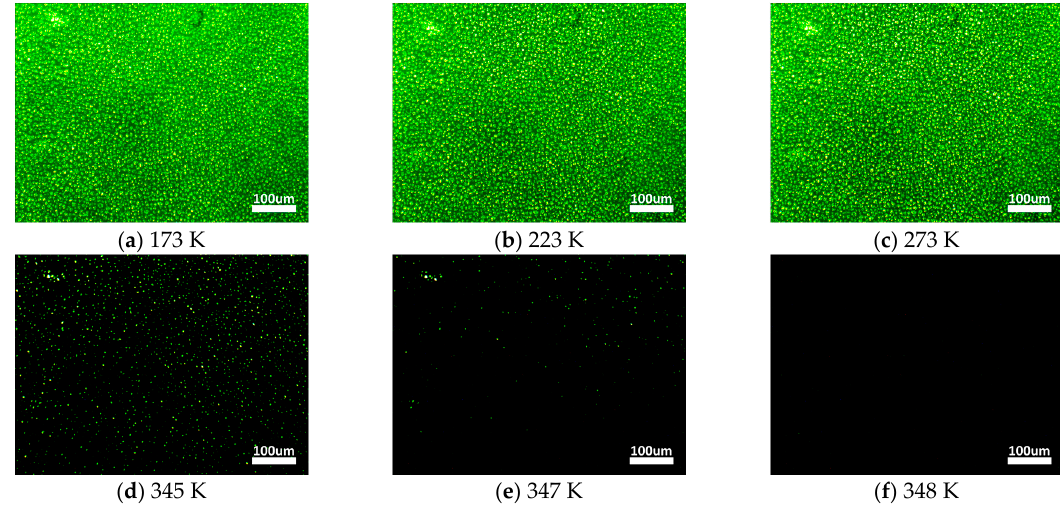
Figure 3. Transmission images of the templated SPLC phase transition from 173 K to 348 K.